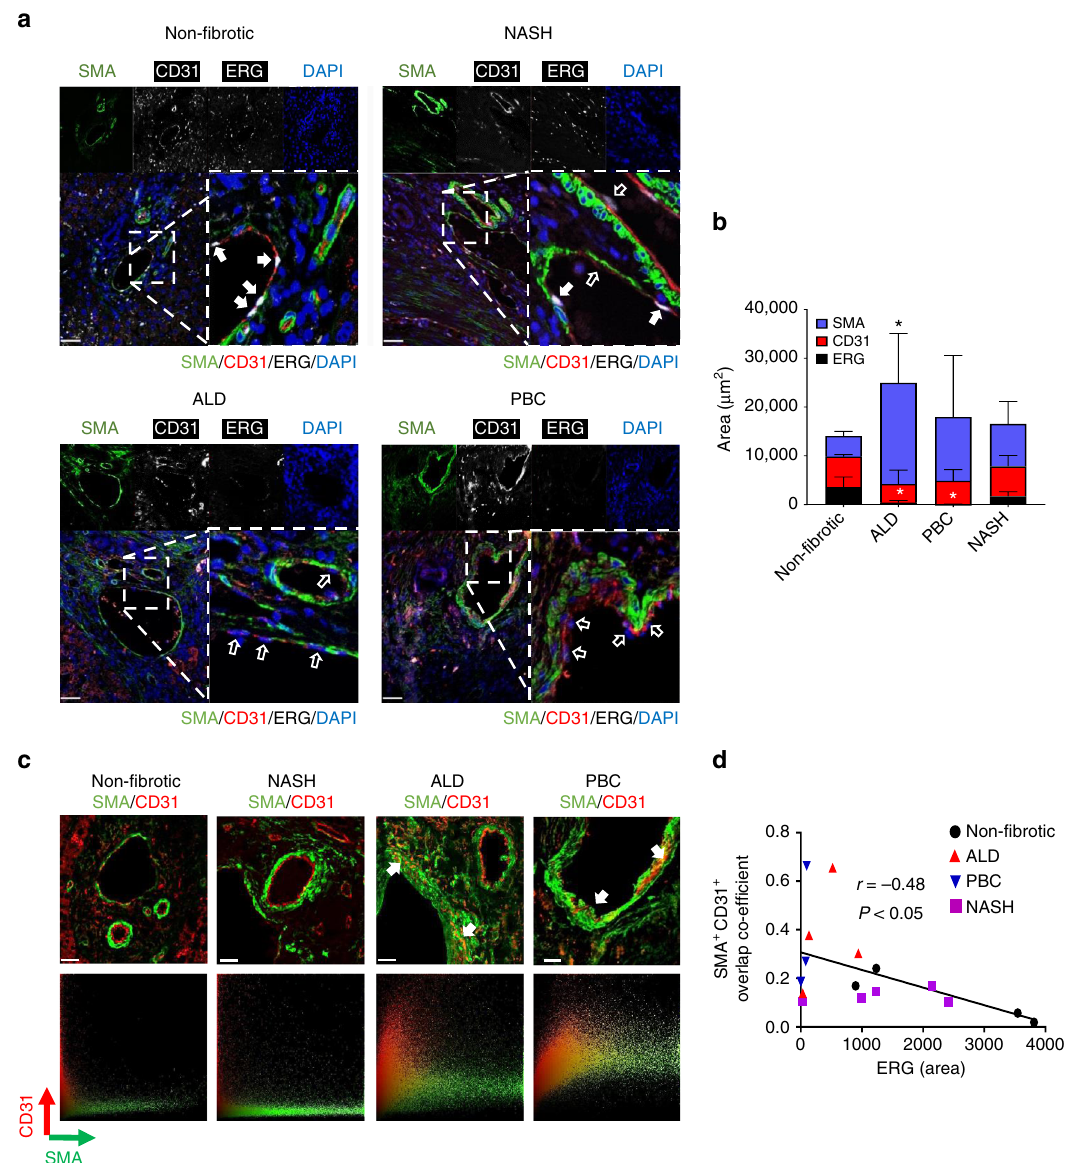
Fig. 7 Loss of ERG expression correlates with EndMT in end-stage human liver disease. a Representative immuno fl uorescence of human liver sections stained for SMA (green), CD31 (grey scale; red in merge), ERG (white) and DAPI (blue) were captured from non- fi brotic donor patients with chronic end ‐ stage NASH, PBC and ALD with enlarged merge panel. Filled white arrows identify CD31 + ERG + EC whereas empty white arrows show CD31 + ERG − EC (Scale bar 50 µ m). b Quanti fi cation of SMA, CD31 and ERG expression ( fi ve fi elds per section, n = 4 – 5). Scale bar 20 μ m. Data were compared to non- fi brotic group (*) by one-way ANOVA and Dunnett ’ s comparison post-test. c Representative images for CD31 (Red) and SMA (green) staining, showing co-localisation indicative of EndMT (arrows) and their pixel co-localisation pro fi le in ALD, PBC and NASH patient samples. d Quanti fi cation of pixel co-localisation of CD31 (Red) and SMA (green) by overlap co-ef fi cient was correlated with ERG expression for all individual human section data, non- fi brotic (black circles), NASH (purple squares), PBC (blue triangle down) and ALD (red triangle up). Correlation was calculated by linear regression, resulting in a signi fi cant negative correlation. All graphical data are mean ± s.e.m., * P <